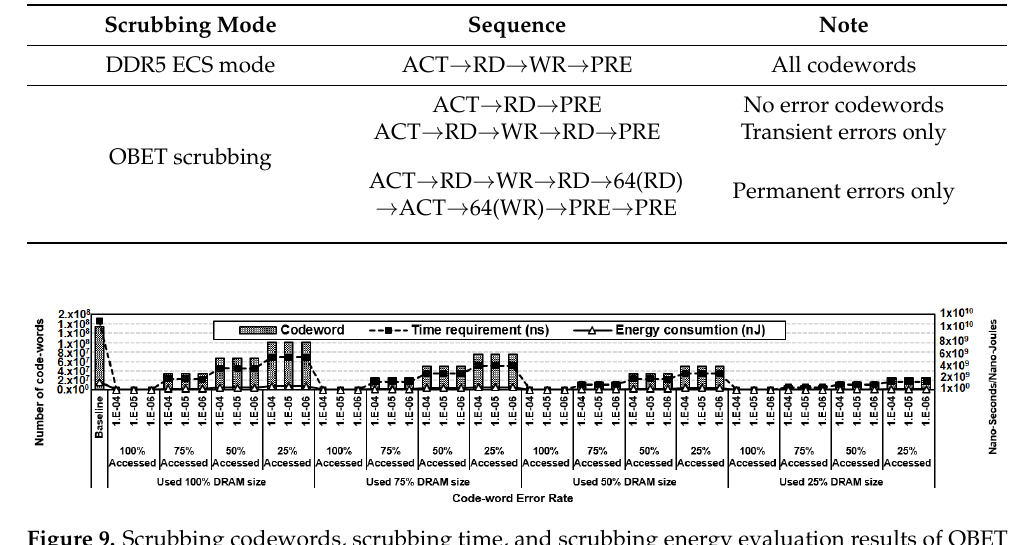
Table 4. Scrubbing sequence comparison between conventional ECS mode and OBET scrubbing.